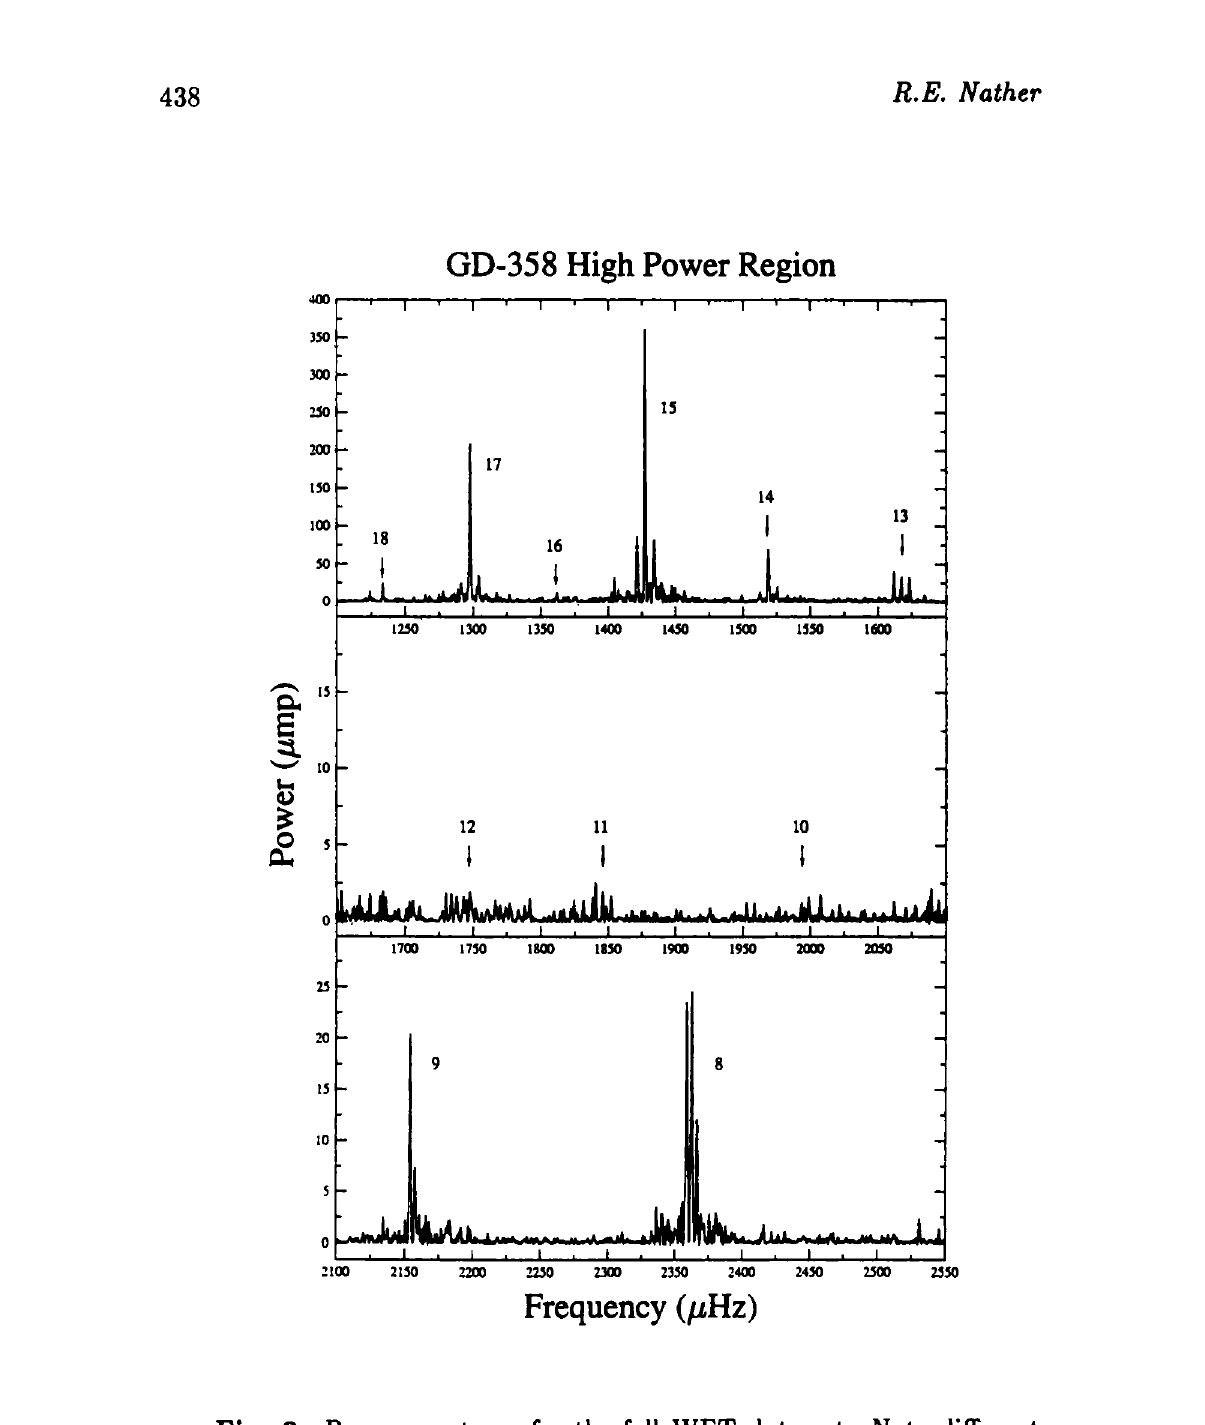
Fig. 2. Power spectrum for the full WET data set. Note different scale in the three